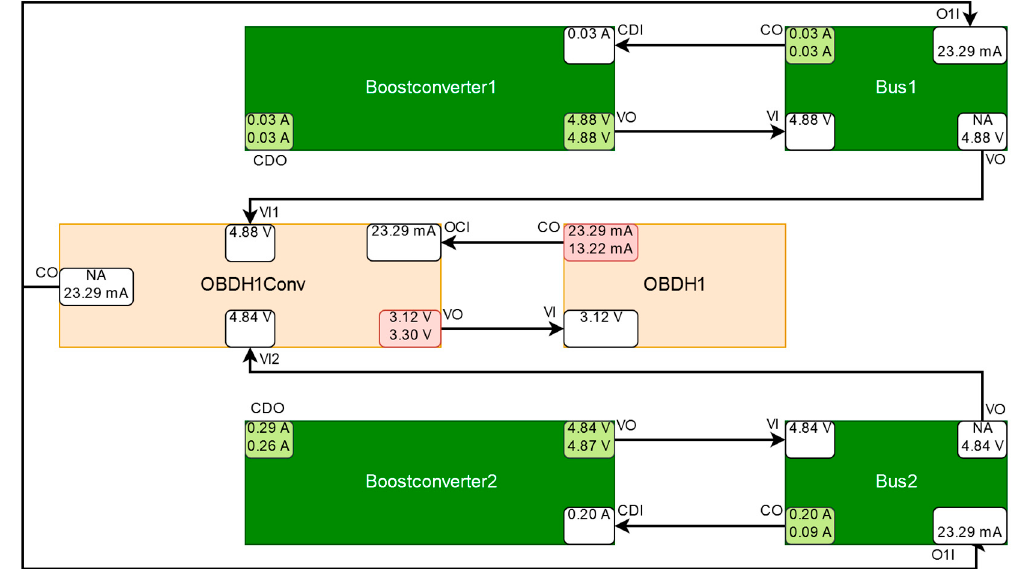
Figure 25. Simplified schematic depiction of the suspected component OBDH1Conv and OBDH1 and its relevant surrounding components. In addition to the explanation of Figure 20, OBDH1Conv and OBDH1 are depicted in a lighter shade of red to indicate that the probability of their respective diagnosis is lower than in the previous experiments.